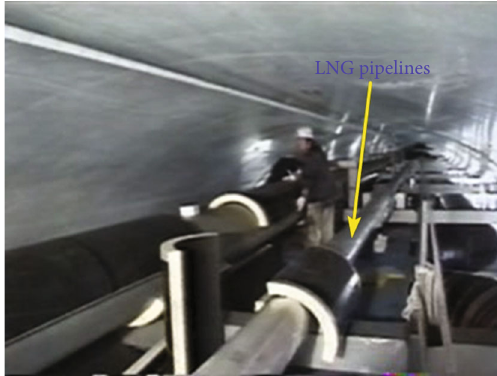
Figure 1: Tunnel for LNG pipelines in Ohgishima.